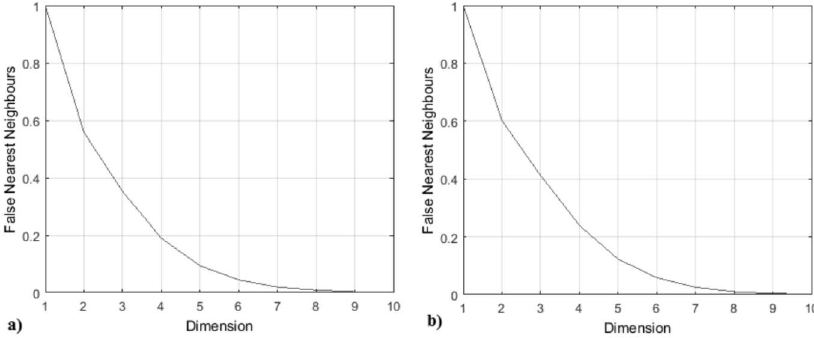
Figure 4. False nearest neighbours for the EHG signal: